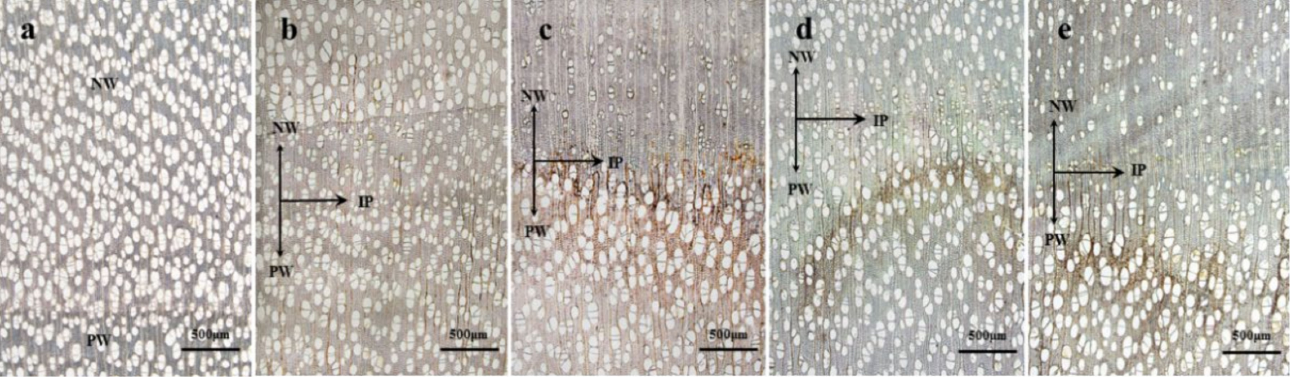
Figure 3. Cross section of poplar (4 × ), ( a ) for the unmodified treatment group, ( b – d ) for the 110,100 mmol/L TEOS modification treatment group, and ( e ) for the SiO 2 colloidal modification treatment group. PW for previously grown wood, IP for injection point, NW for newly grown